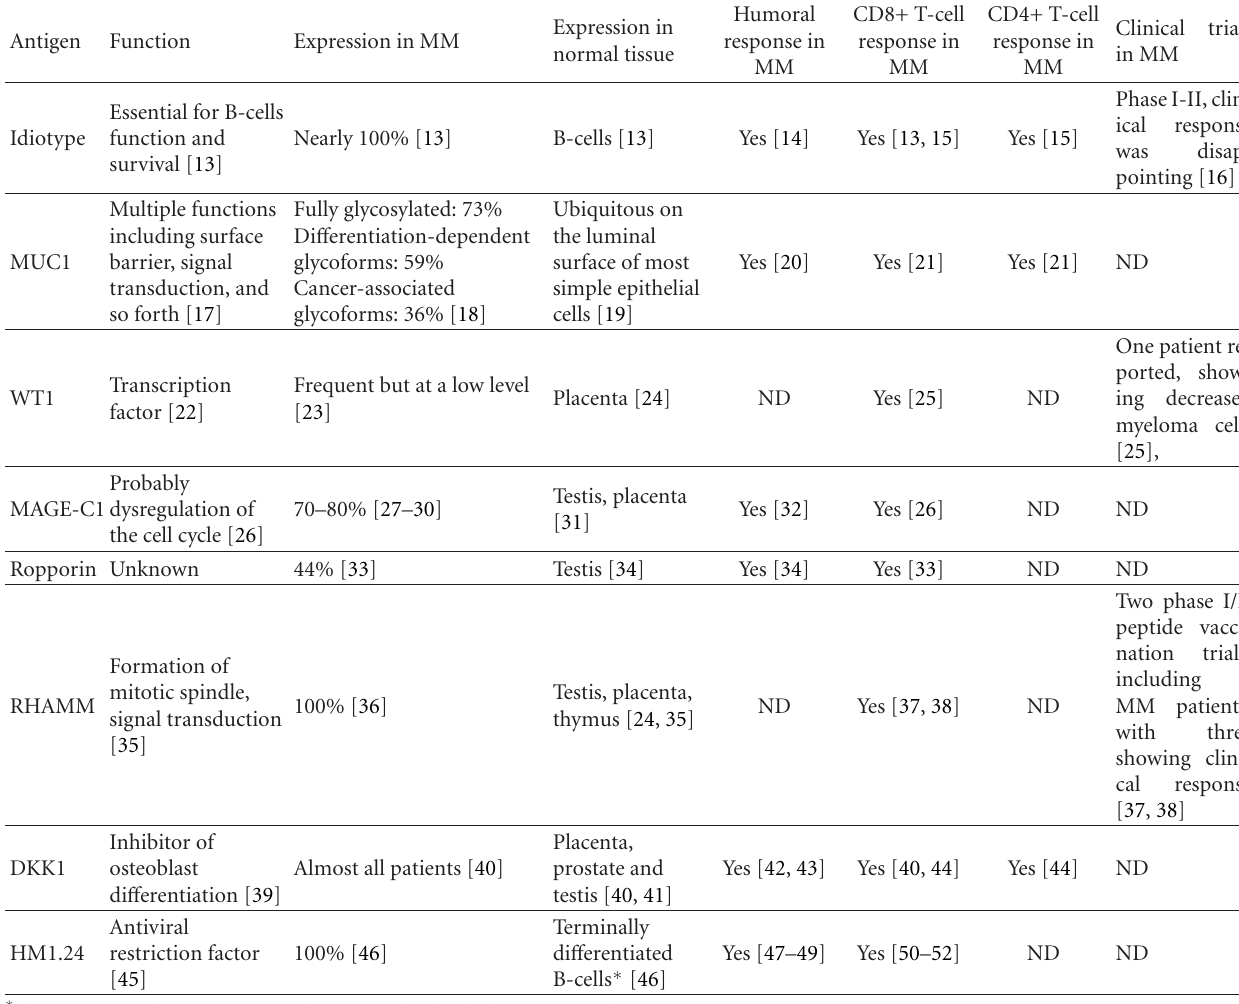
Table 1: Expression profile and immune responses of promising immunotargets in